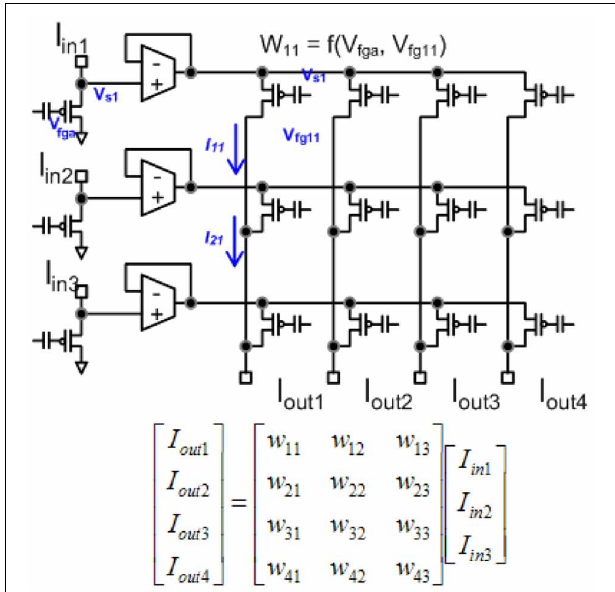
FIGURE 19 | Programmable floating-gate transistors performing a vector matrix multiply using current-domain mathematics.